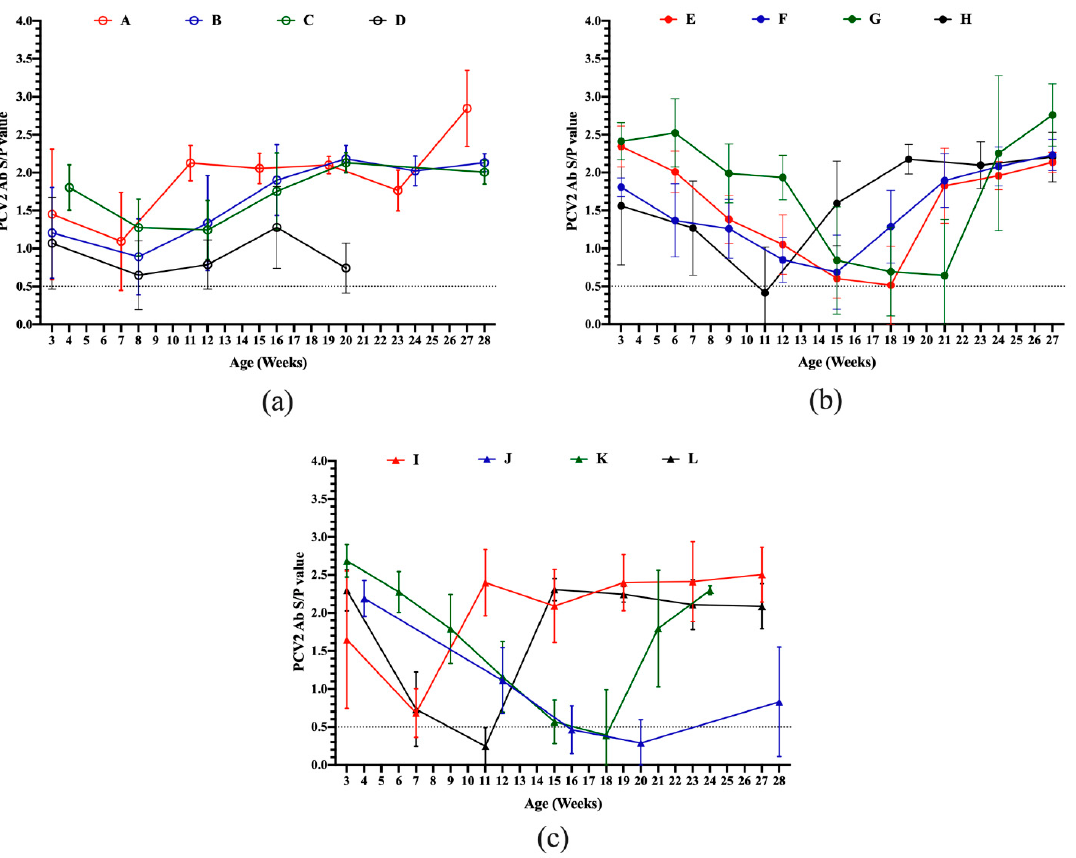
Figure 2. Serodynamic profile of porcine circovirus type 2 (PCV2) measured by BioCheck ELISA in different aged pigs born from different sow immunization programs against PCV2 from different farms. ( a ) sows without PCV2 vaccination (Farms A, B, C, and D); ( b ) sows with mass PCV2 vaccination (Farms E, F, G, and H); ( c ) PCV2 vaccination in sows at 2-4 weeks pre-farrowing (Farms I, J, K, and L).